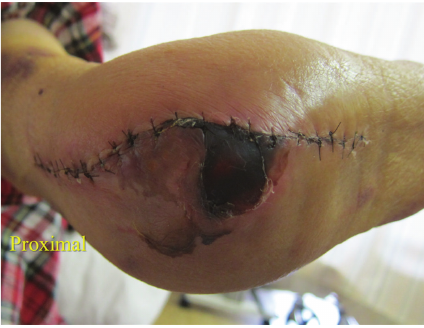
Figure 3: A wound dehiscence led to an exposure of the tip of the olecranon.